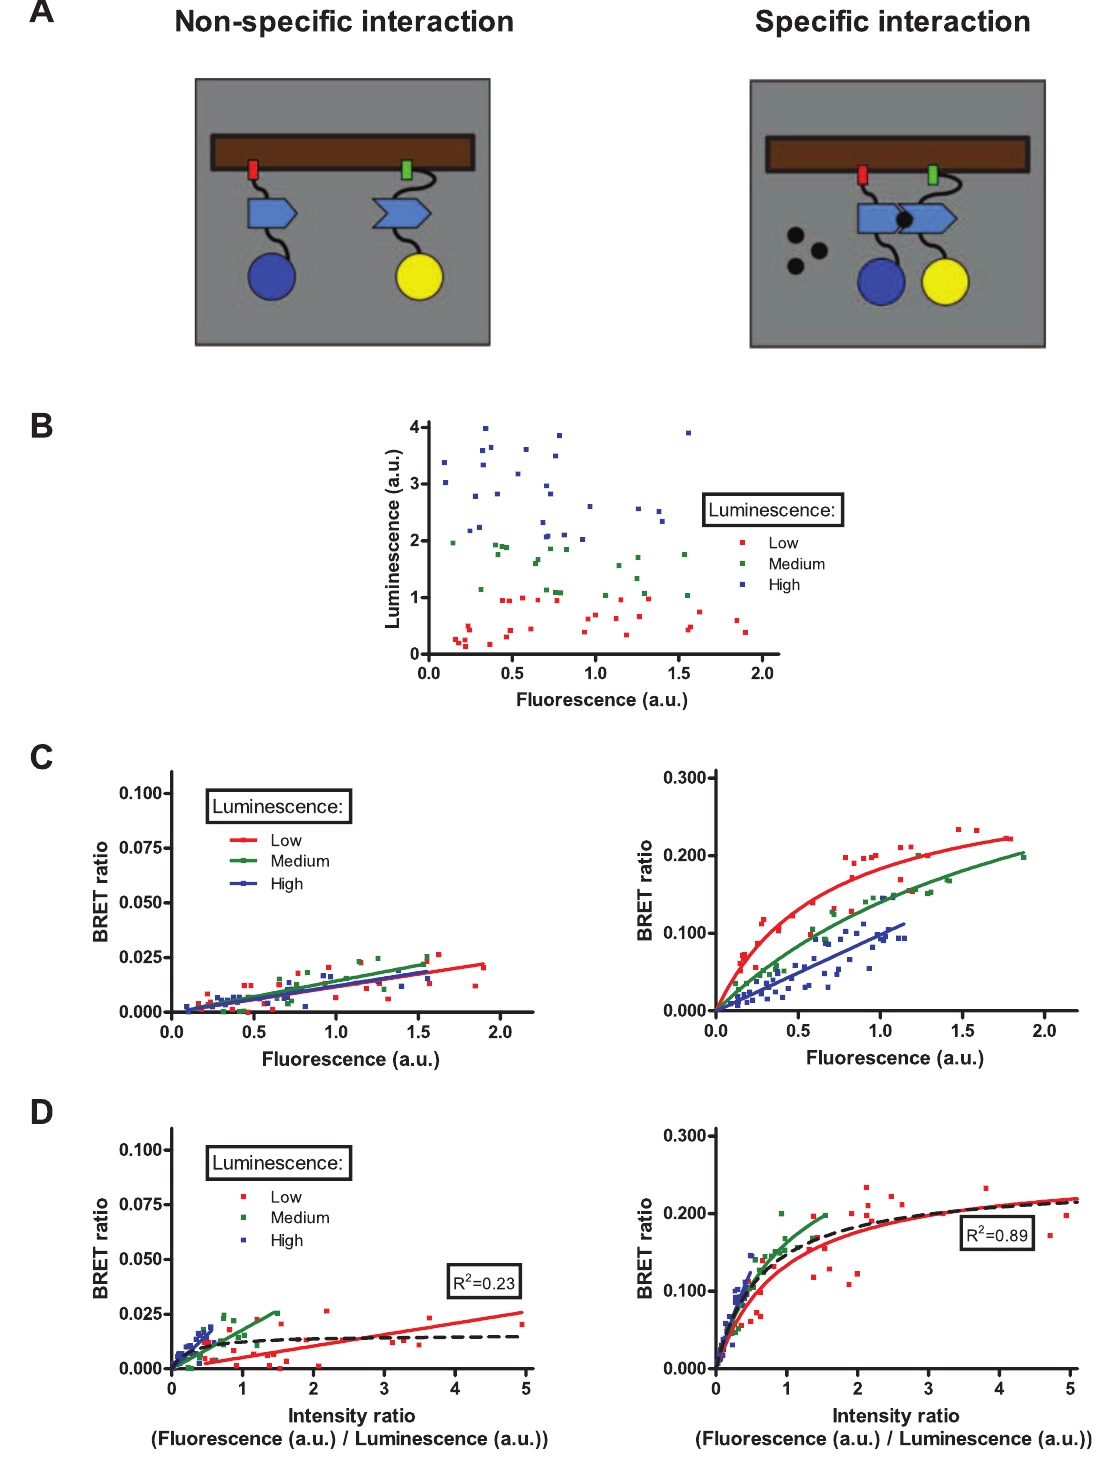
Figure 3. Rapamycin inducible dimerization with various donor amounts. (A) Schematic representation of the rapamycin inducible dimerization system: PM2-FKBP-RLuc (left molecule) and Venus-FRB-CAAX (right molecule) show non-specific interaction in the absence of rapamycin (left panel), while the presence of rapamycin (right panel) results the dimerization of FKBP and FRB domains, converting the interaction into specific. (B, C and D) HEK293 cells were transiently transfected with increasing amounts of PM2-FKBP-RLuc and Venus-FRB-CAAX, while empty pcDNA3.1 plasmid was added to maintain total transfected plasmid amount constant. Fluorescence-Luminescence plot (B) shows a wide and independent distribution of acceptor and donor expression. Cells were treated with vehicle (left panels) or 100 nM rapamycin (right panels) 30 minutes prior to measurements. Total luminescence and Venus fluorescence were measured at the beginning of each experiment, and intensity ratio was calculated as fluorescence/total luminescence. BRET ratio was calculated as Emission 530 /Emission 485 , and was plotted as a function of measured fluorescence (C)